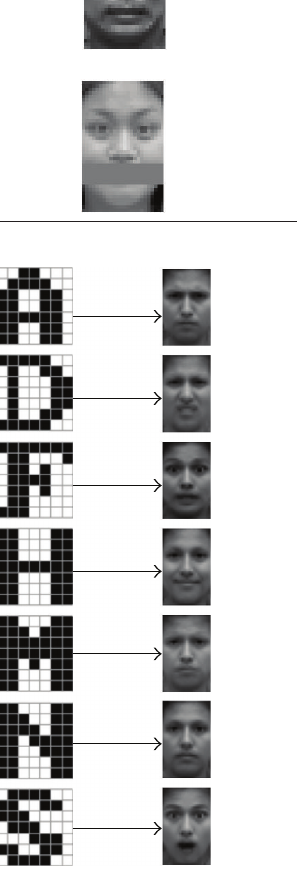
Figure 16: Pictures reconstructed using the emotion